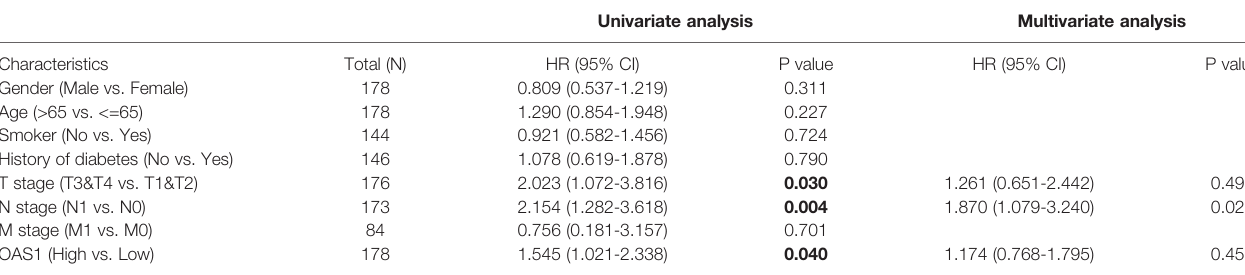
TABLE 2 | Univariate/multivariate Cox regression